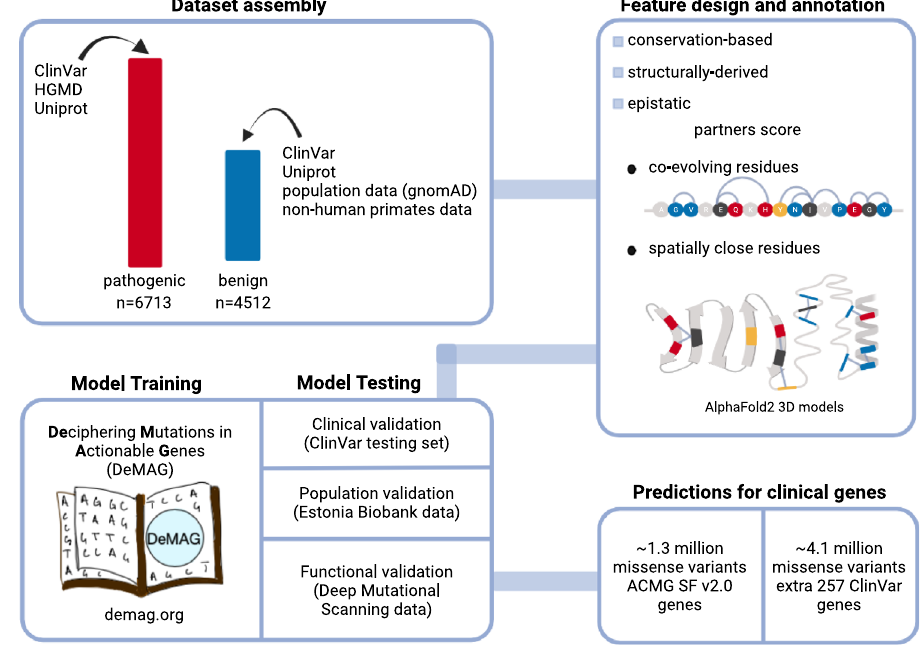
Fig. 1 |OverviewofDeMAG(Deciphering MutationsinActionableGenes). First, we assembled a training set from 59 actionable genes; pathogenic variants were collected from clinical databases such as ClinVar and Human Gene Mutation Database (HGMD 40 ). The benign class includes variants from different sources including clinical, population, and non-human primate variants. The training set consisted of 6713 (60%) pathogenic and 4512 (40%) benign variants. Next, we annotated each variant with features, including EVmutation 18 , IUPred2A 75 , and AlphaFold2 40 con fi dence score (predicted Local Distance Difference Test,